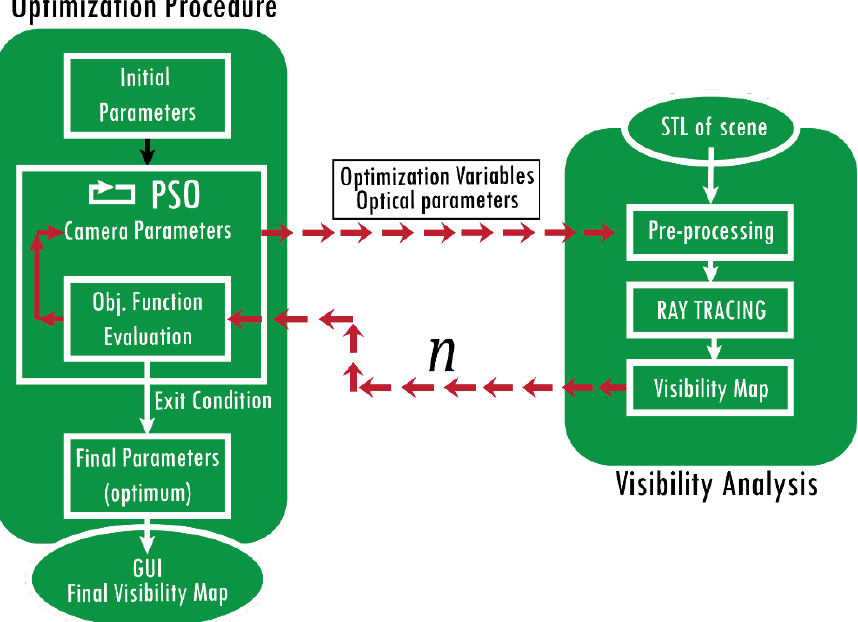
Figure 1. Framework of the method: optimization procedure and visibility analysis.